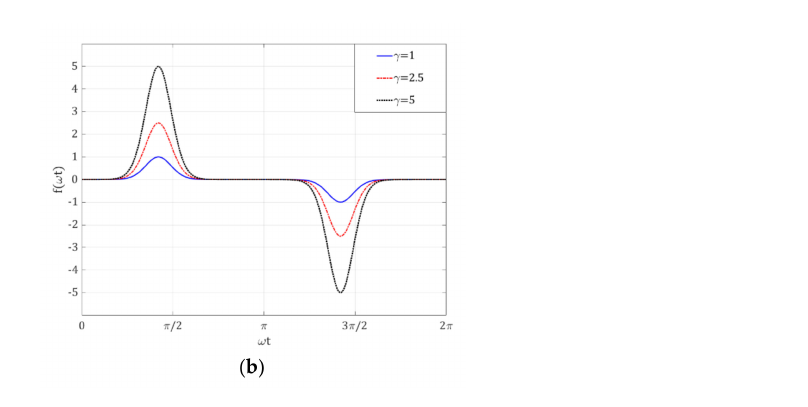
Figure 5. Effect of γ on normalized hysteresis loops ( a ) and corresponding functions ( b ).